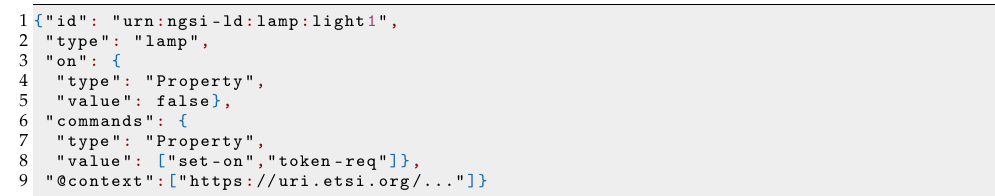
Table 7. NGSI-LD of a lamp.